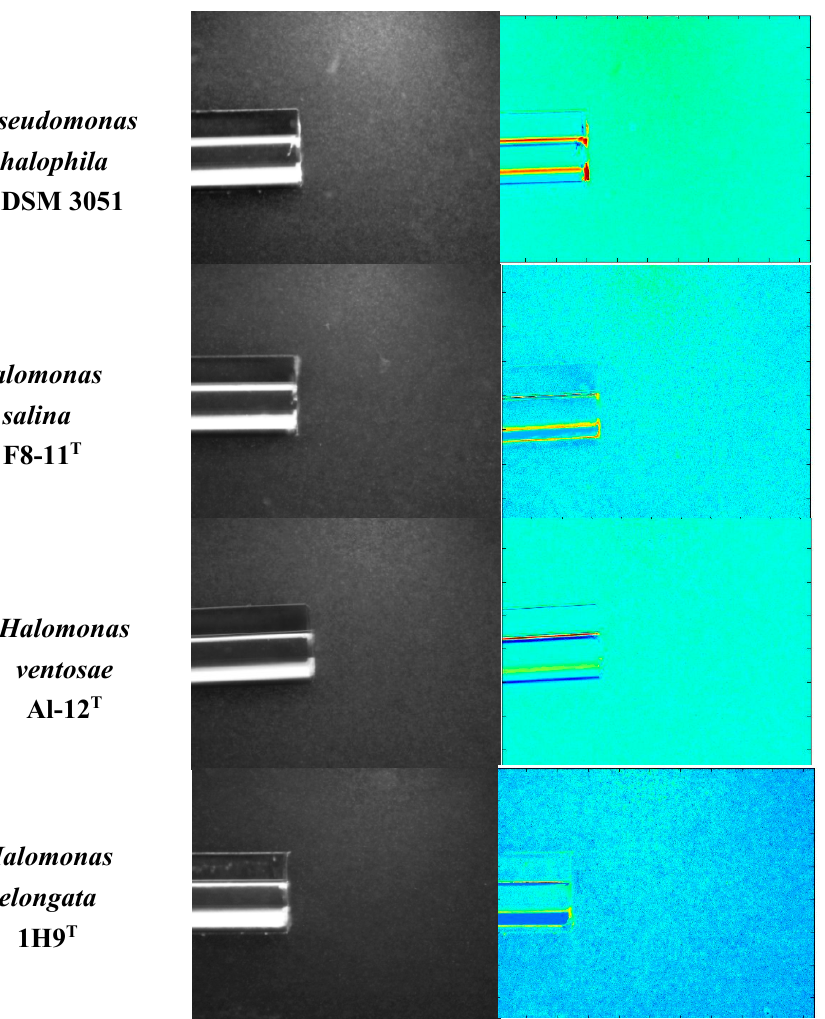
Figure 3. Qualitative capillary chemotaxis assays comparing responses of four halophilic bacteria to root exudates grown at a 5% (w / v) concentration of sea salt solution. All photographs were taken after 10 min. First column: dark-field images of cells gathered at the mouth of capillaries containing exudates; second column: heat map of normalized images (Matlab R2013a).